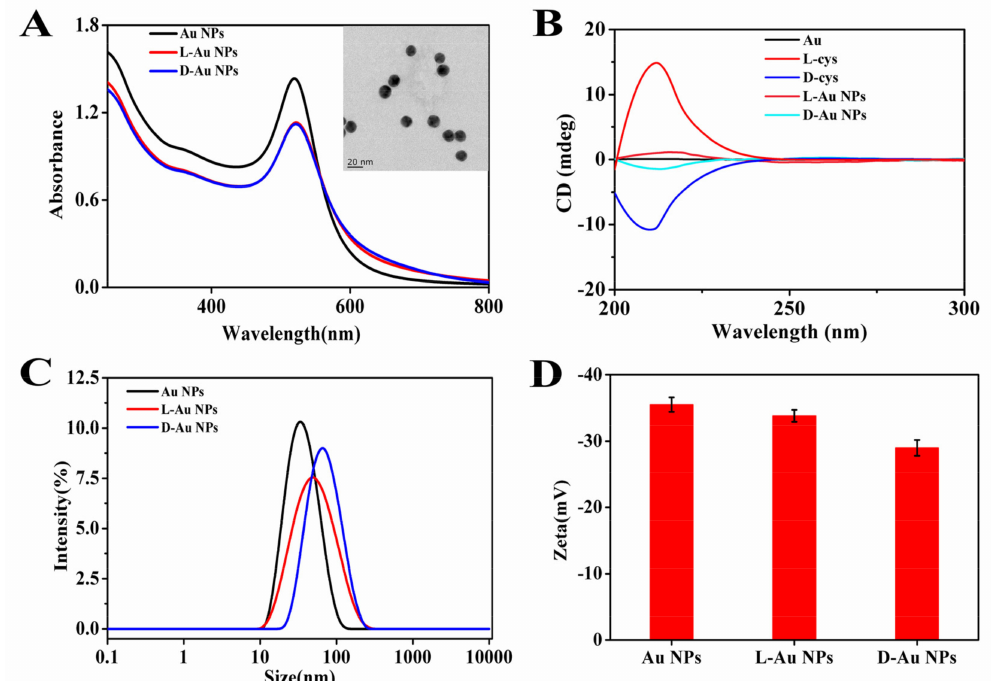
Figure 1. Characterizations of cysteine-functionalized gold nanoparticles( D -/ L -Au NPs). ( A ) Absorption spectrum of Au NPs, L -Au NPs and D -Au NPs (Insert: TEM image of D -Au NPs). ( B ) Circular dichroic spectrum, ( C ) particle size distribution and ( D ) zeta potential of Au NPs and chiral Au NPs. (Dates are presented as the mean ±